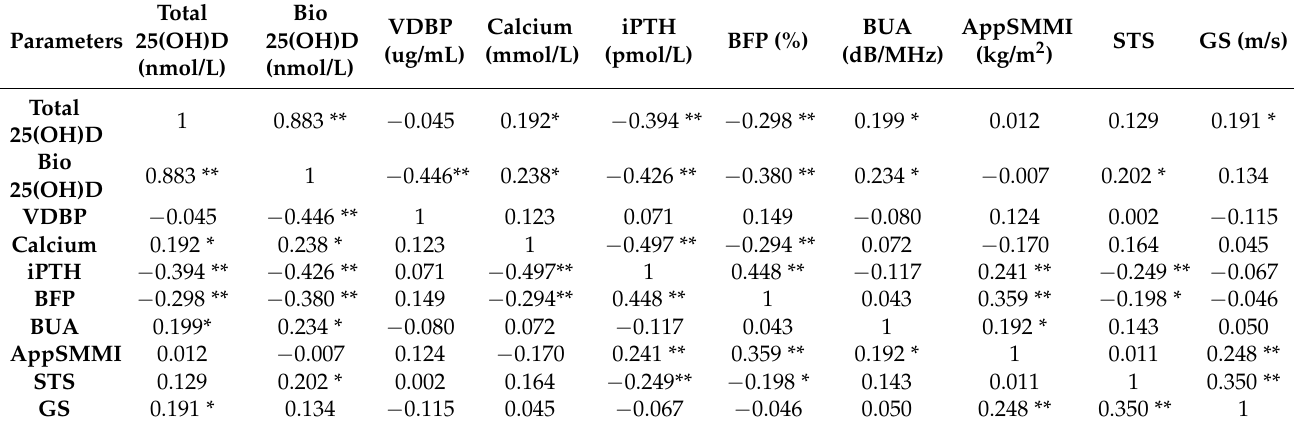
N.B: appSMMI = appendicular skeletal muscle mass index, BUA = broadband ultrasonic attenuation, BFP = body fat percent, GS = gait speed, iPTH = intact parathyroid hormone, STS = sit-to-stand, VDBP = vitamin D binding protein, 25(OH)D = 25-hydroxyvitamin